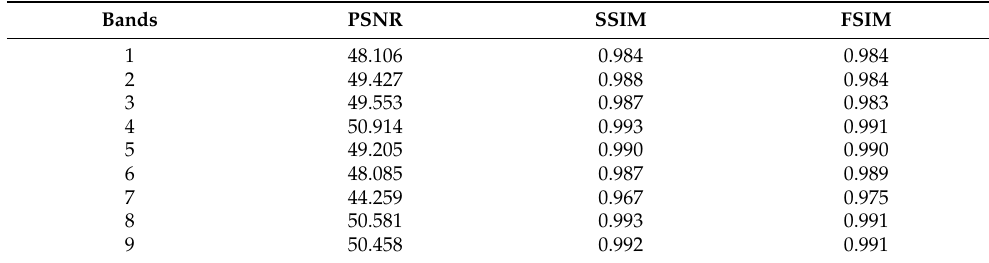
Table 1. Compression ratio (20.7):1 over 400 epochs ReLU for the Lombardia Sentinel-2 dataset. Bands